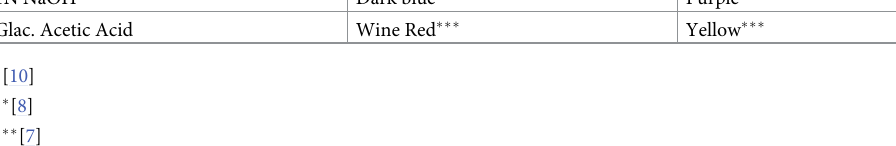
We conclude that the color of the pigmentation is influenced by pH. At high pH the pig- mentation is red and at low pH yellow. We attribute both colors to the same chemical com- pound Xanthomegnin. We demonstrate that T . rubrum change the pH of cultivation media. One medium change to alkaline condition, another medium to acid condition. On the first medium T . rubrum has a wine-red pigmentation, on the other a yellow pigmentation.